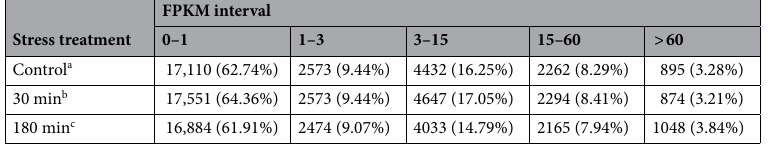
Table 2. Fragments per kilobase of exon per million mapped reads (FPKM) of blood samples subjected to transportation stress. a Not transported but held in pens; b Transported for 30 min; c Transported for 180 min.